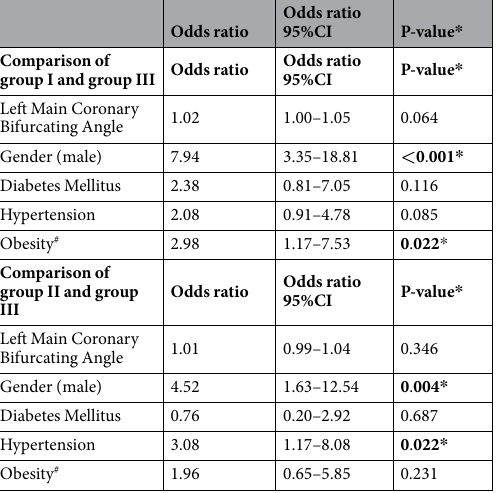
Table 2. Multivariate analysis of demographic data, risk factors and left main coronary bifurcating angle. Group I = presence of significant stenosis of either the left anterior descending artery, the left circumflex artery or both. Group II = presence of plaques in either the left anterior descending artery, the left circumflex artery or both, but without associated significant stenosis, Group III = Normal subjects who had negative findings on coronary CT angiography, with a zero calcium score. * Denotes statistical significance, with a p value < 0.05. # Since multicollinearity exists among hypertension, diastolic blood pressure, obesity and body mass index, we choose one of these (obesity) as a representative for